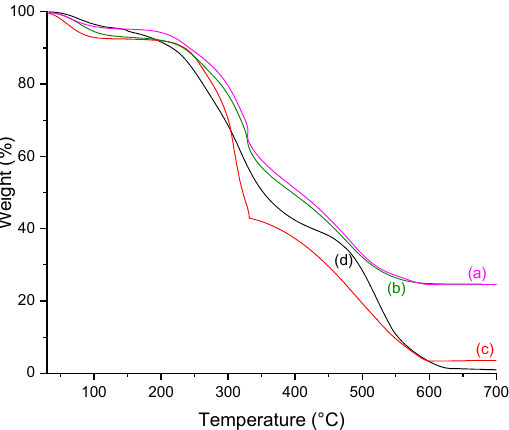
Figure 6. TGA curves for (a) CP25, (b) C10P25; (c) C10P37; (d) CP; and (e) C10P.